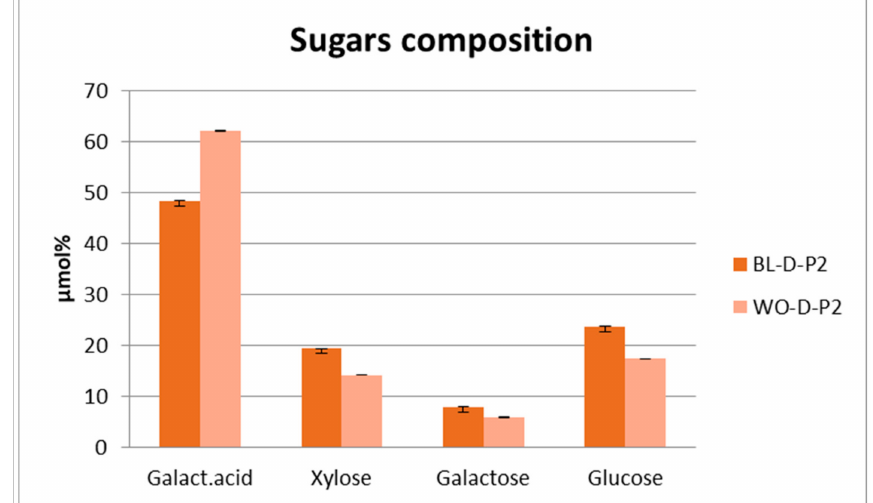
Figure 3. Sugar composition of the polysaccharide fraction (D-P2) of Black and Wonderful varieties. Data are expressed in µ mol (%) as a mean of three independent